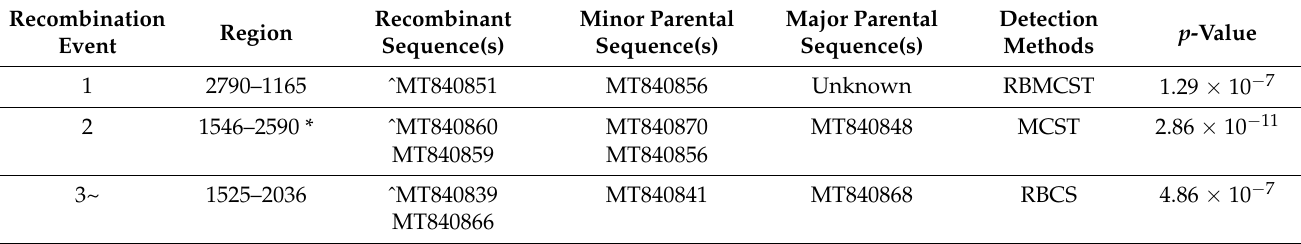
Figure 4. ( A ) Neighbor-joining phylogenetic tree of the 32 Opuntia becurtovirus sequences. Branches with <60% bootstrap branch support have been collapsed and the tree is midpoint-rooted. ( B ) Maximum-likelihood phylogenetic tree of the 32 Opuntia becurtovirus sequences with recombination regions removed. Graphical representation of each genome representing the recombination event with the breakpoint location within the genome. Table 3. Summary of the three recombination events detected in the Opuntia becurtovirus by RDP5 v.5.5. The methods used to detect recombination were RDP (R) GENCONV (G), BOOTSCAN (B), MAXCHI (M), CHIMERA (C), SISCAN (S), and 3SEQ (T). The method with the highest p -value for each recombination event is bolded. Sites where the actual breakpoint is undetermined are marked with *. Recombinant sequences marked with ^ indicate that the recombinant sequence may have been misidentified (one of the identified parents might be the recombinant).